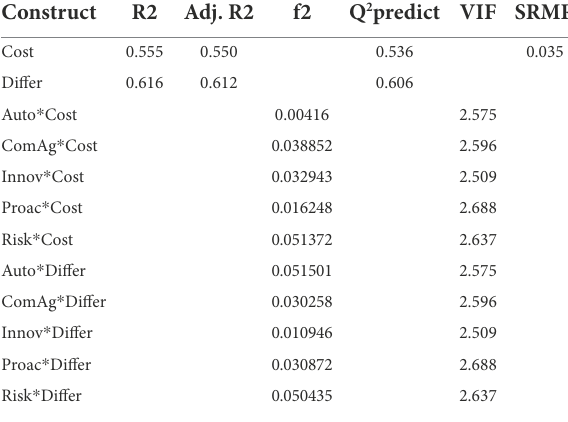
TABLE 5 Structured model